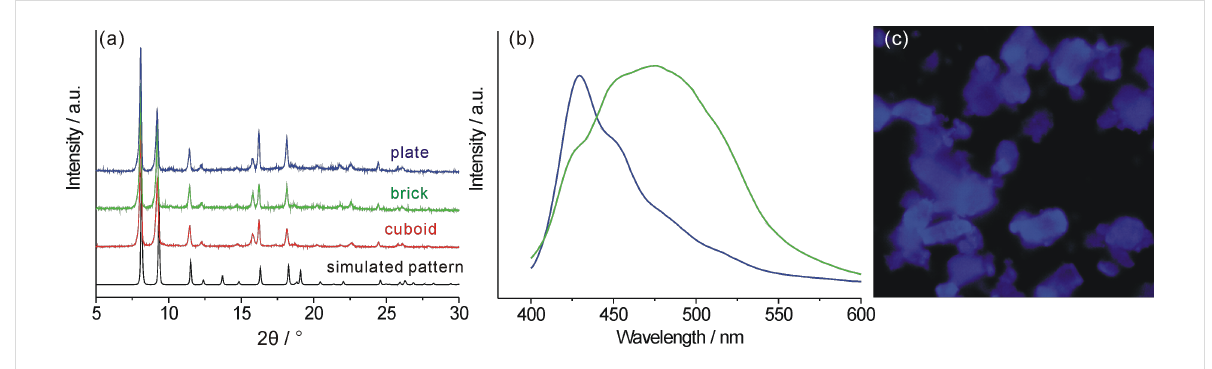
Figure 3: (a) Powder diffractograms of the nanocrystalline products (cuboid (50 mM Zn–adc/50 mM dabco); brick-like (50 mM Zn–adc/25 mM dabco), and plate-like (25 mM Zn–adc/12.5 mM dabco)) in comparison with the one simulated from [Zn 2 (adc) 2 (dabco)] single-crystal data. The minor differ- ences between the powder XRD patterns and the simulated one may result from different guests in the MOF pores. (b) Solid-state emission spectra of as-synthesized [Zn 2 (adc) 2 (dabco)] nanocrystals (loaded with solvent molecules such as DMF, green curve) and in the dried bulk form (blue curve). (c) Fluorescence image of a DMF-free sample. Excitation wavelength was 365 nm.